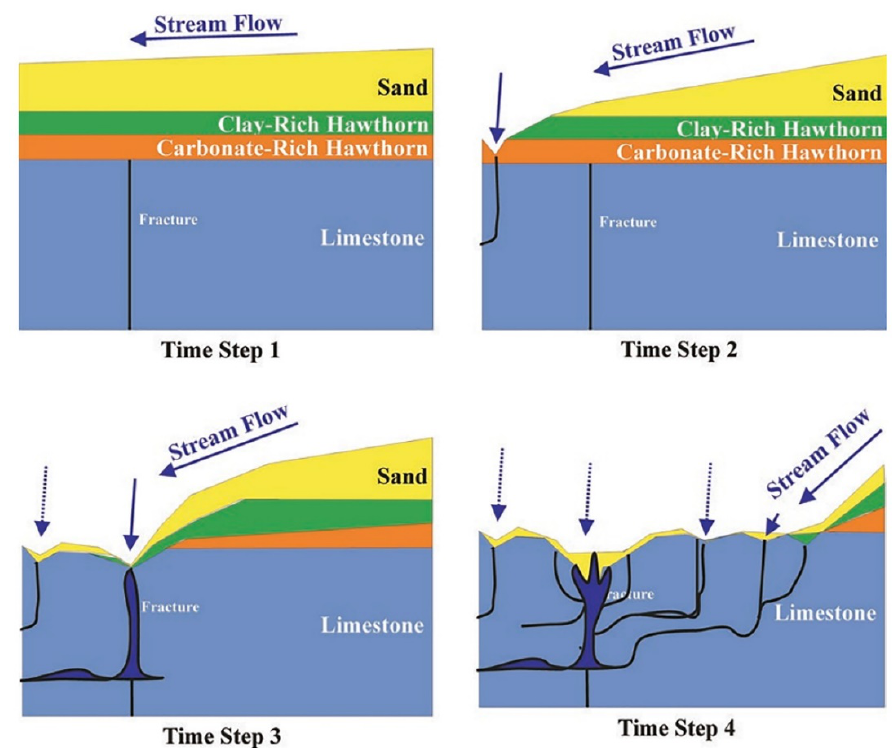
Figure 4. Subsidence dolines above main passages and tributary passages [18].